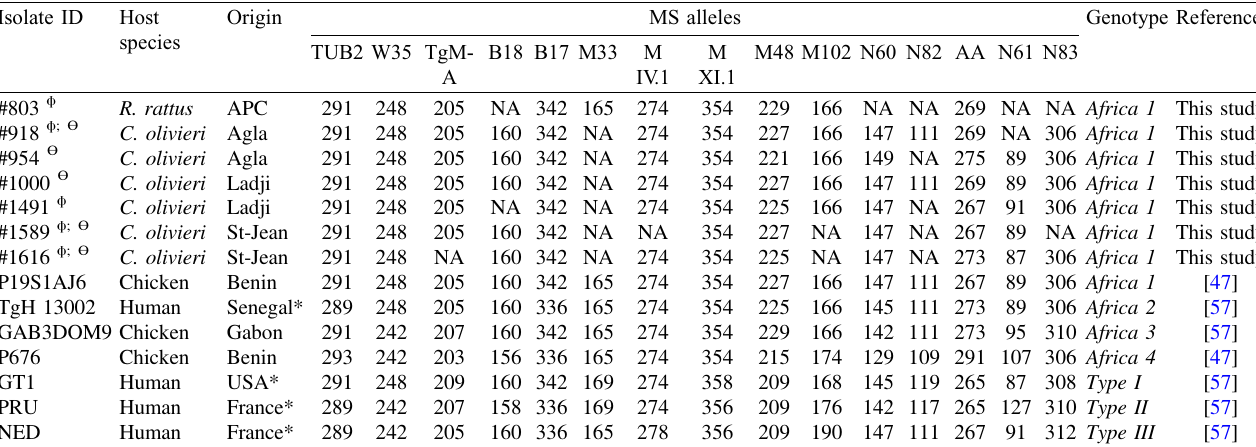
Table 1. Multilocus microsatellite (MS) genotyping of micromammal-borne Toxoplasma gondii from Cotonou. Isolate